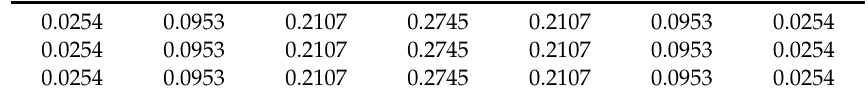
intervals of rotation, and the direction with highest di ff erenced value was